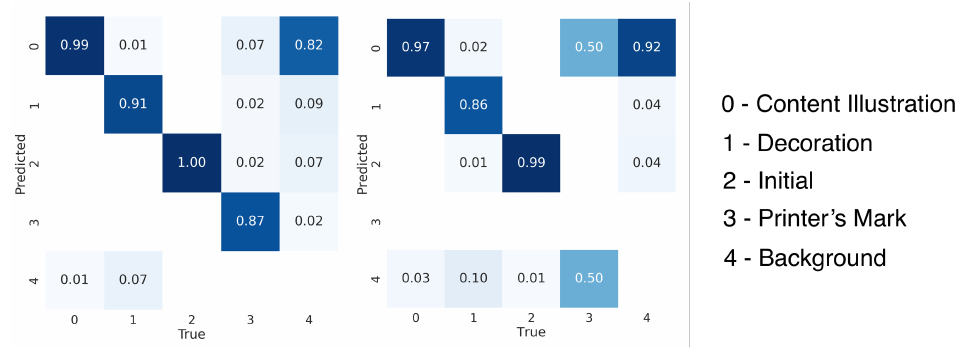
Figure 4. Class confusion tables for ( Left ) YOLOv5 (S-VED extended , 640 × 640, confidence threshold = 0.2), ( Right ) Faster-RCNN (S-VED extended , 1280 × 1280, confidence threshold = 0.7).